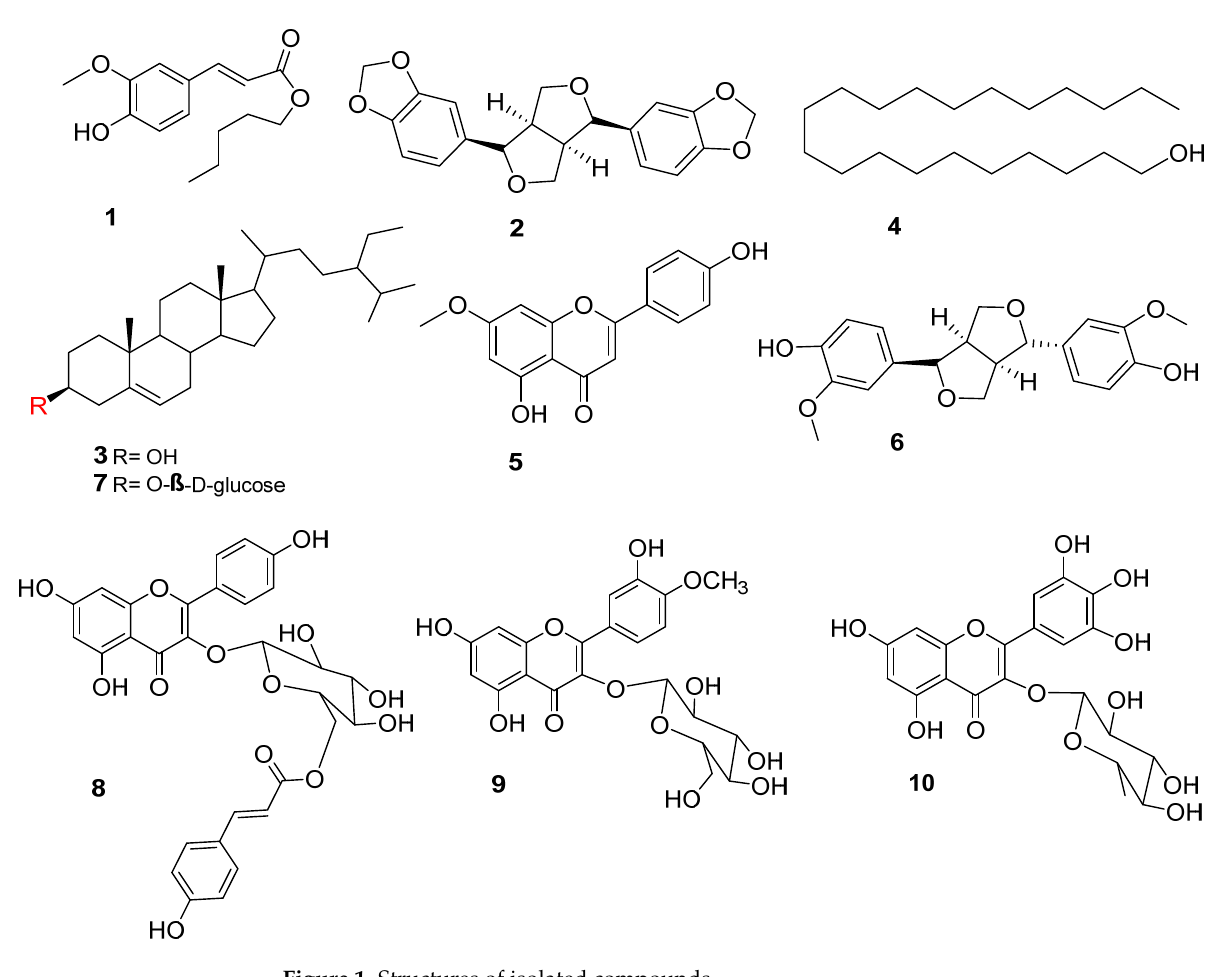
Figure 1. Structures of isolated compounds.